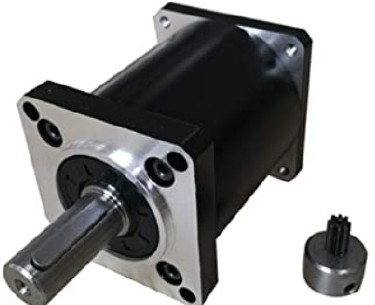
Figure 2. Speed reducer .